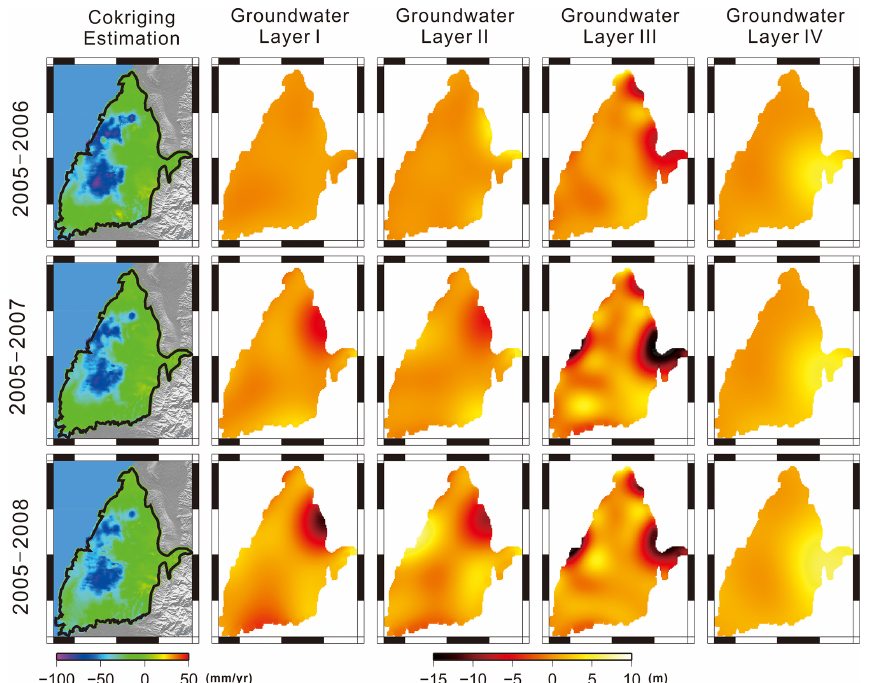
Figure 3. First column is the cokriging estimation in the three intervals (2005–2006, 2005–2007 and 2005–2008). The rest columns are the difference of yearly average of groundwater level in four